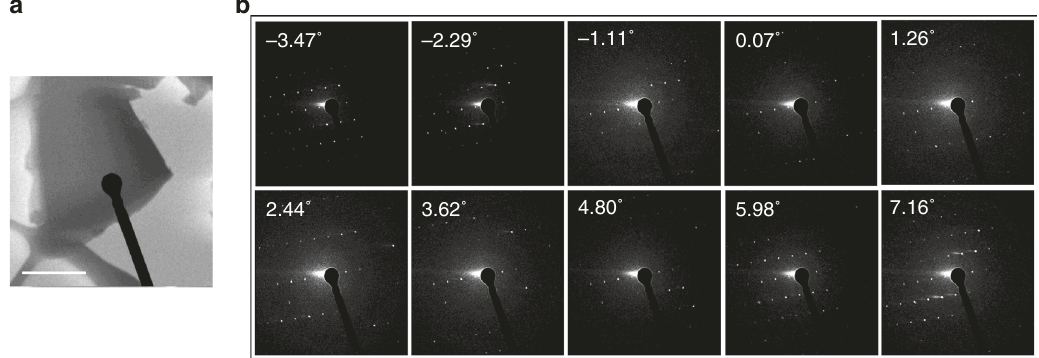
Fig. 1 TEM image and a series of ED patterns of an L -histidine microcrystal. a TEM image of an L -histidine microcrystal on a ultra-thin carbon fi lm obtained immediately after the ED measurement. b Selected ED patterns of the L -histidine microcrystal during continuous rotation. The number of each frame represents a starting rotation angle of each ED patterns. The diffraction patterns were obtained